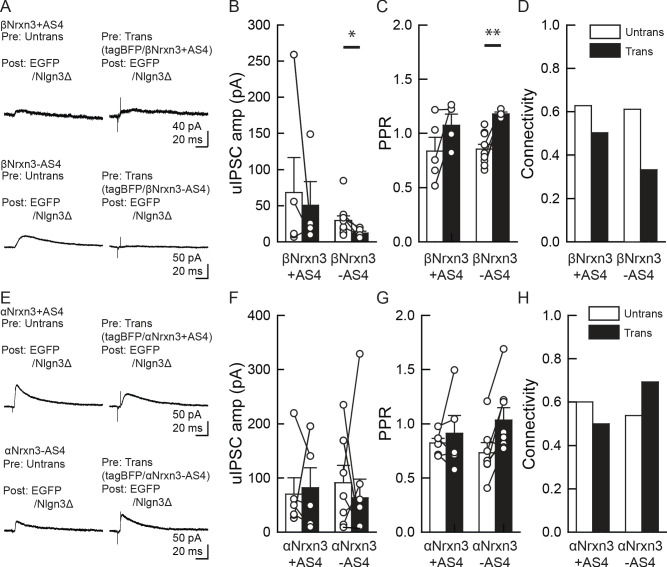
α/βNrxn3–Nlgn3Δ synaptic signals do not regulate VGT3+ inhibitory synapse transmission.(A–D) Effect of pre- and postsynaptic overexpression (OE) of βNrxn3(±AS4) and Nlgn3Δ, respectively, on unitary inhibitory synaptic transmission in organotypic slice cultures prepared from NrxnTKO/VGT3/RFP mice. (E–H) Effect of pre- and postsynaptic OE of αNrxn3(±AS4) and Nlgn3Δ, respectively, on unitary inhibitory synaptic transmission. (A and E) Averaged sample unitary inhibitory postsynaptic current (uIPSC) traces. Summary of uIPSC amplitude (B and F), paired-pulse ratio (C and G), and connectivity (D and H). Numbers of cell pairs: βNrxn3+AS4, βNrxn3-AS4, αNrxn3+AS4, and αNrxn3-AS4 at VGT3+ synapses (eight pairs/three mice, 9/3, 5/3, and 11/3). The number of tested slice cultures is the same as that of cell pairs. Mann–Whitney U-test.